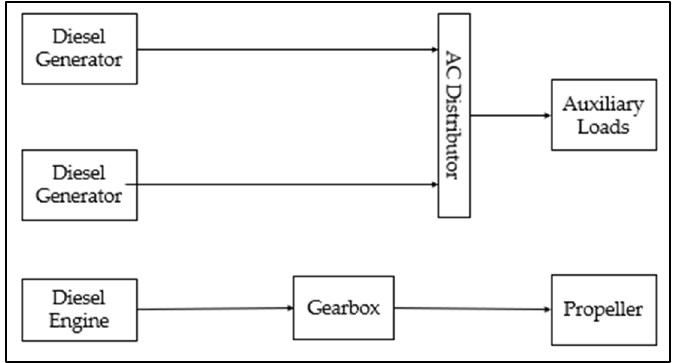
Figure 1. Simplified power flow for diesel–mechanical propulsion power system.